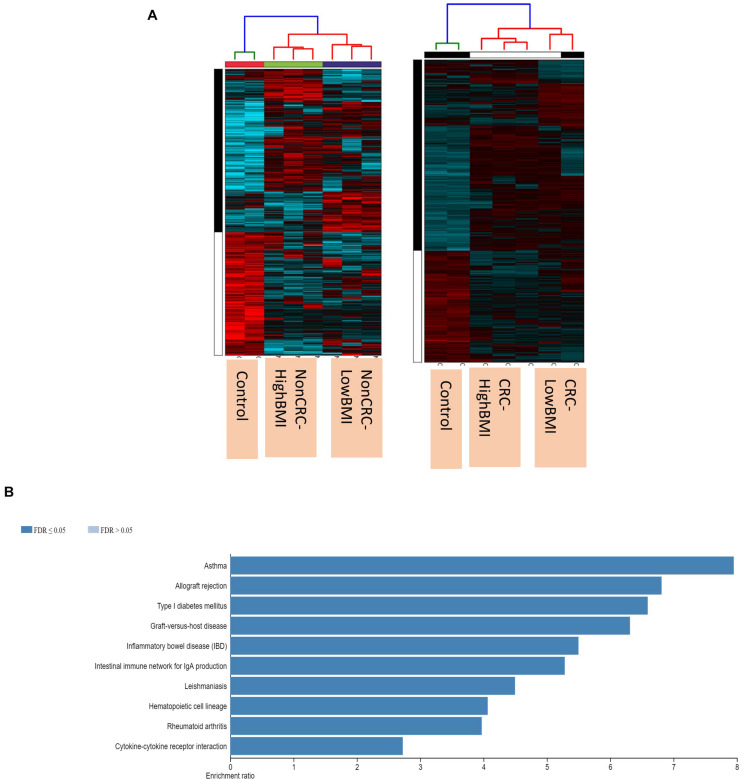
(A) Heatmap and clustering of the expression of the Non-CRC and CRC EVs-treated T cells. (B) Enriched pathways of the set of genes that were differentially expressed in T cells treated with CRC and Non-CRC EVs.